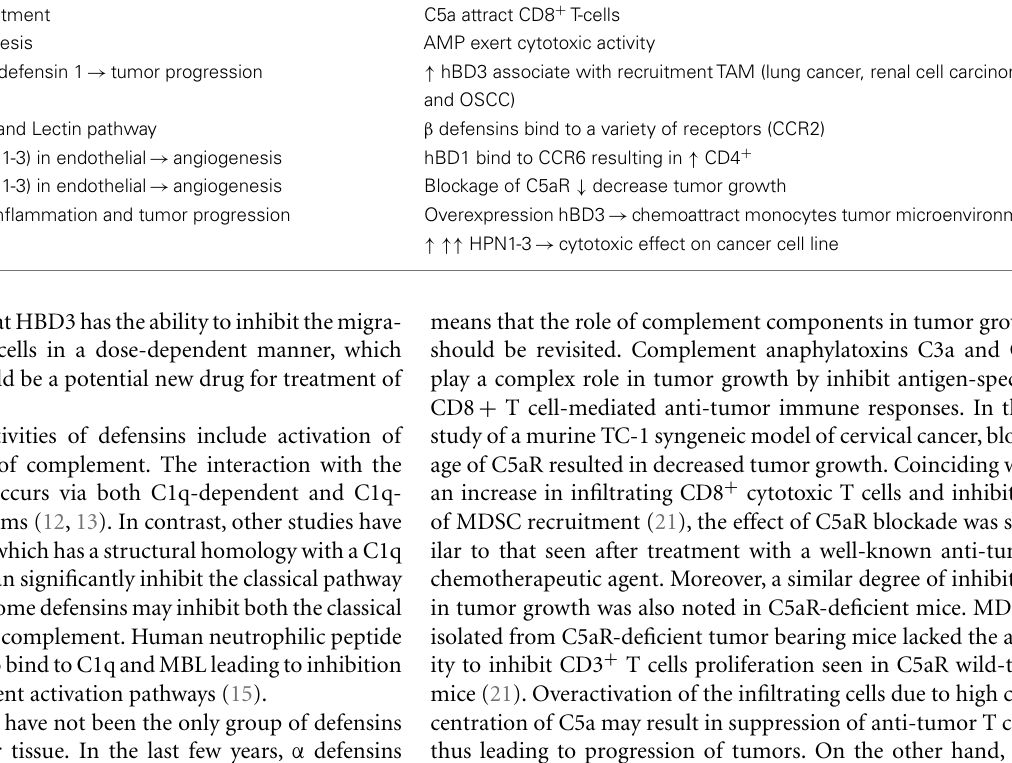
Table 1 |Tumors develop a complex network of cellular interactions involving both proinflammatory and suppressive cells .